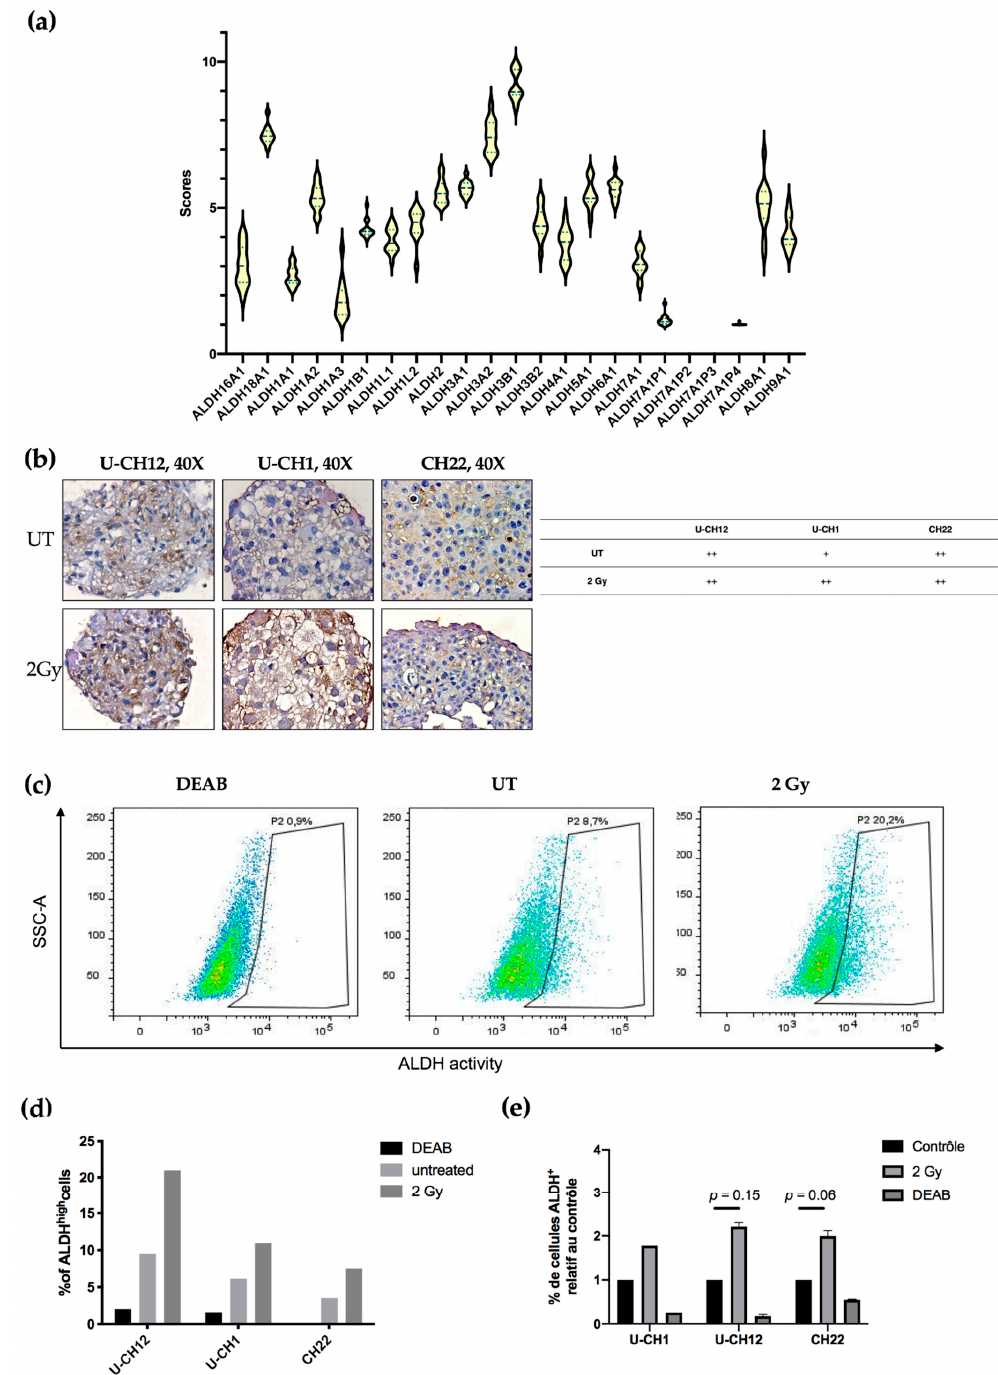
Figure 4. Aldehyde dehydrogenase (ALDH) is a promising radiosensitizing target in chordoma: ( a ) a graph representing ALDH gene expression scores in 13 chordoma patients, ( b ) representative images of ALDH3A2 staining after 2 Gy of X-rays or in untreated controls and quantification, ( c ) images representative of an Aldefluor assay quantifying ALDH1 and 3 activity in response to 2 Gy of X-rays in U-CH12 spheroids, ( d ) graph representative of the percent of ALDH high cells, and ( e ) graph representative of the percent of ALDH high cells relative to untreated conditions. Diethylaminobenzaldehyde (DEAB), an inhibitor of ALDH activity, was used as a negative control. The experiment was performed three times in triplicate for U-CH12 and CH22 spheroids, allowing for a comparison between the UT and 2 Gy groups using 2-way ANOVA. The p -value is indicated for each